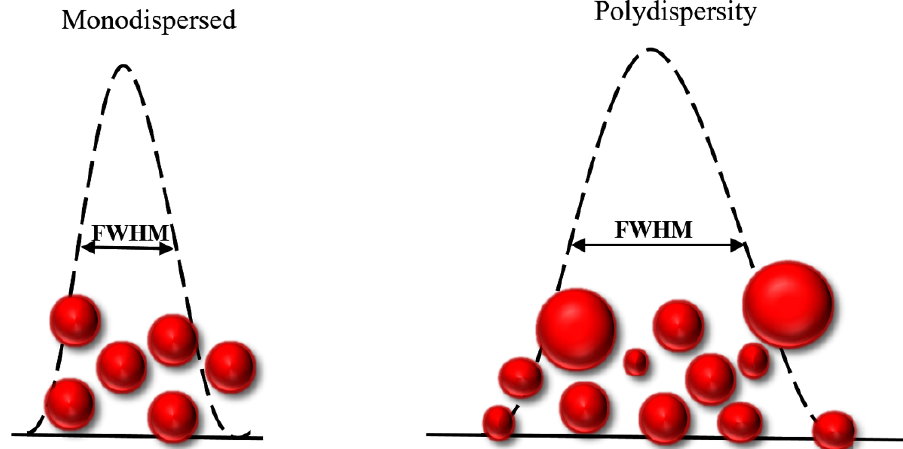
Figure 1. Concept of narrow and width size distribution. Low FWHM indicates monodisperse AuNPs and higher values indicate polydispersity of AuNPs.